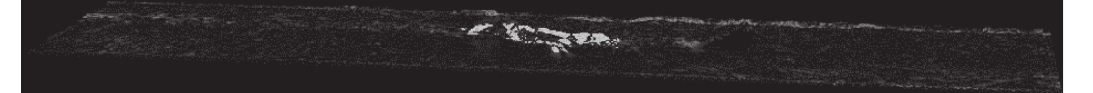
Figure 6: Successive frames difference between the frames i − 1 and i . The high intensities correspond to the movement of the swimmer or the water. Swimming Championships in Limoges, France, April